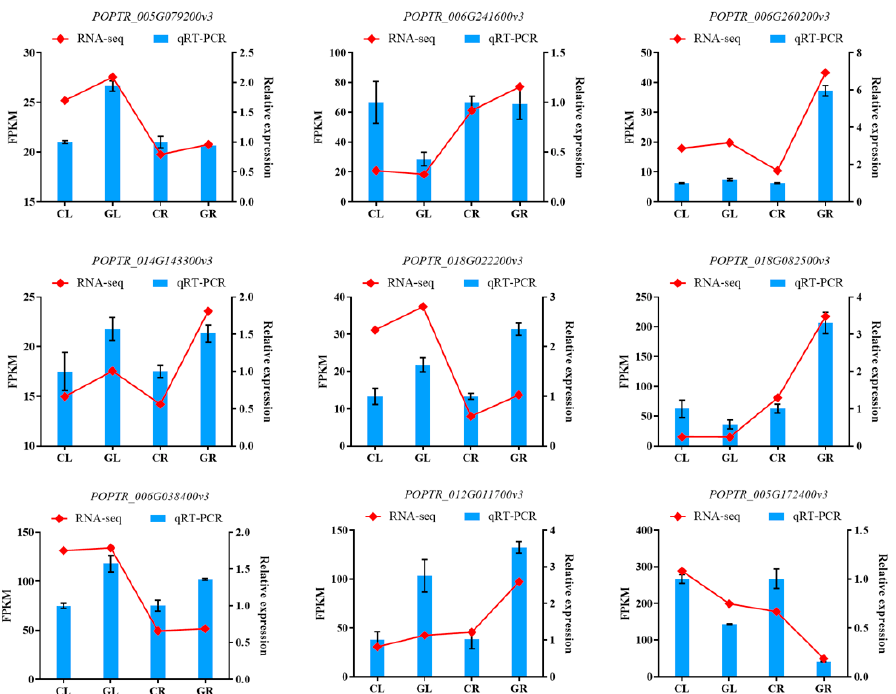
Figure 11. The qRT-PCR validation of selected DEGs in poplars fertilized with Gln compared with the inorganic N. CL, CR, GL and GR represent the shoots and roots samples of the inorganic N control and those of the Gln treatment, respectively.